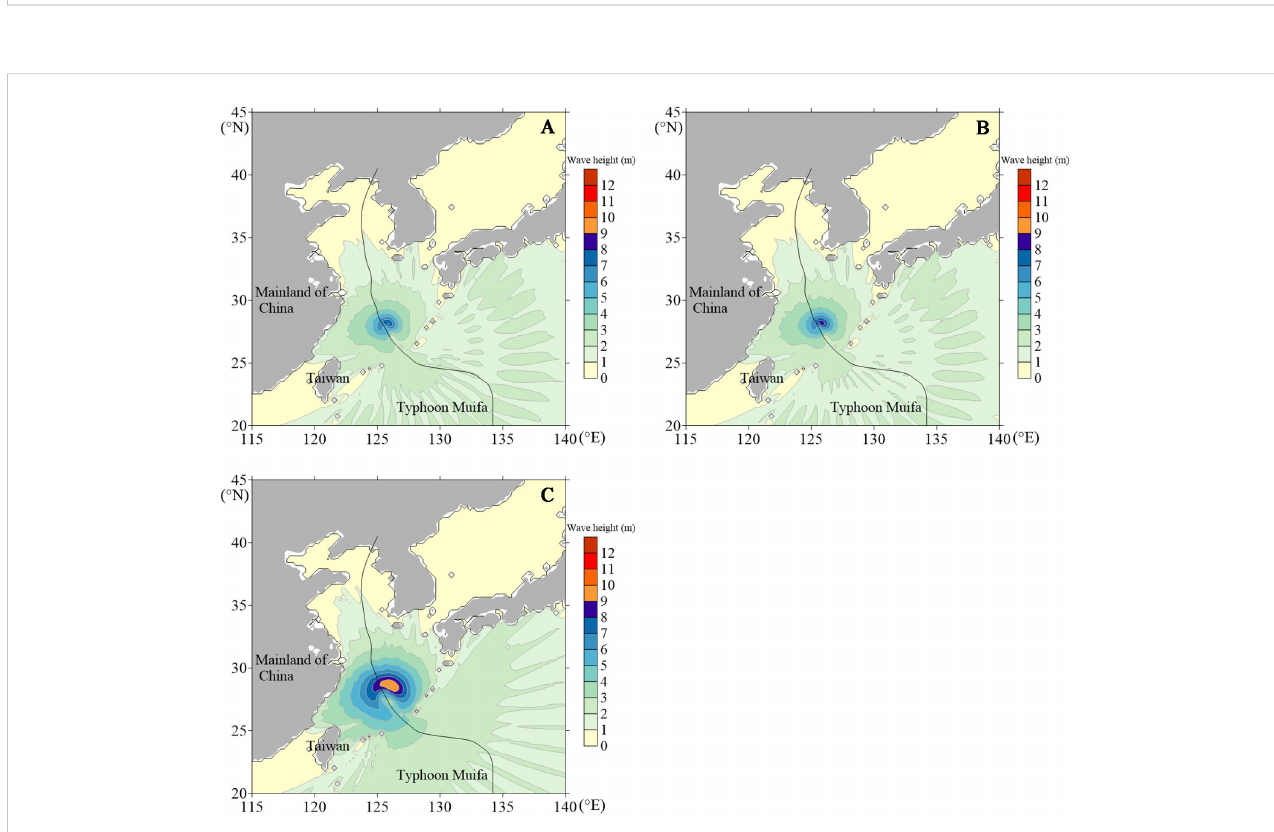
FIGURE 8 Distribution map of the wave fi eld of Typhoon Muifa at 0000 UTC 6 August 2011: (A) symmetrical wind fi eld, (B) superimposed wind fi eld, (C) asymmetric wind fi